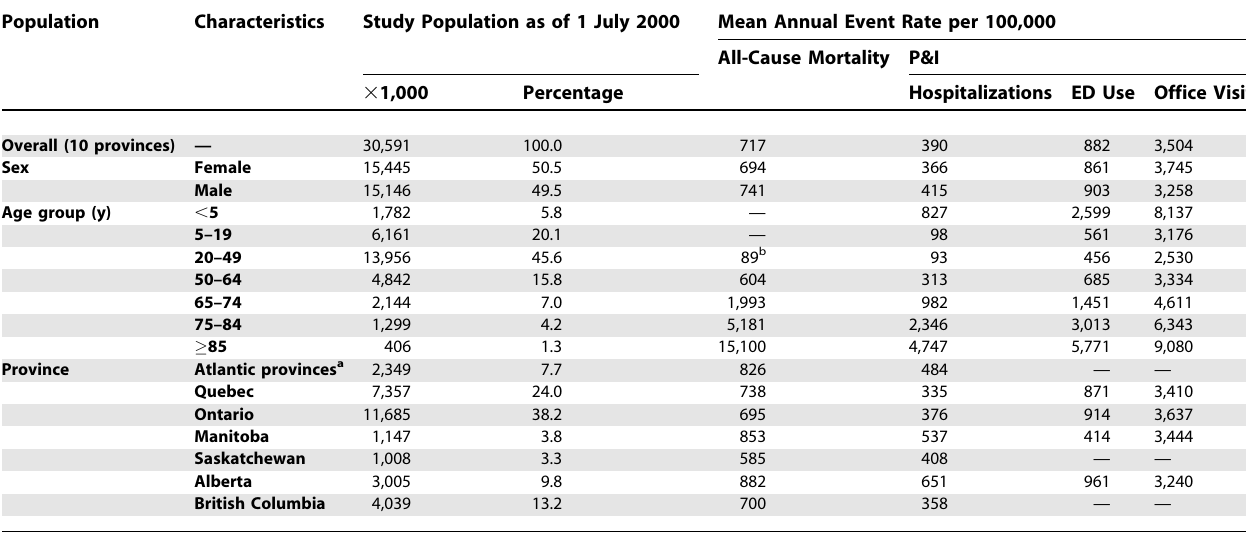
Table 1. Study Population Demographics and Mean Annual Event Rates over Study Period